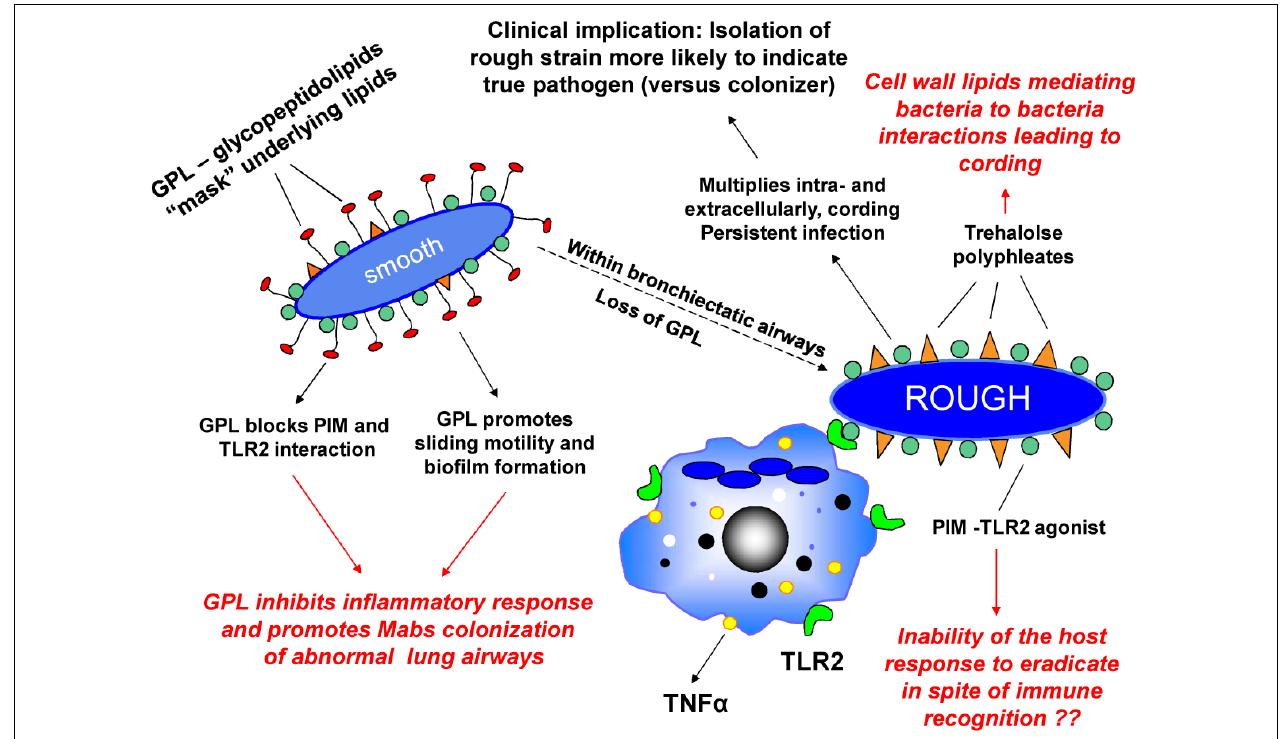
FIGURE 1 | Environmental Mycobacterium abscessus ( MABS ) isolates have the smooth colony morphotype and express glycopeptidolipid (GPL). GPL in the outermost aspect of the cell wall “masks” underlying glycosylated lipoproteins such as phosphatidyl-myo-inositol mannosides (PIMs) involved in immune recognition and blocks the bacterial cell–cell interaction of lipids such trehalose polyphleates which may play a role in clumping and cord formation. By preventing MABS from being recognized by innate immune surveillance mechanisms and promoting biofilm formation, GPL facilitates colonization of bronchiectatic lung airways. After colonization, spontaneous or temperature sensitive loss of GPL is associated with “unmasking” of these molecules. This leads to recognition by TLR2 on macrophages and respiratory epithelial cells resulting in release of the proinflammatory cytokines TNF α (from macrophages) and IL-8 (from respiratory epithelial cells). Rough variants acquire a virulent phenotype characterized by the ability to grow in serpentine cords and cause macrophage apoptosis leading to rapid cell–cell spread and propagation of infection. Isolation of MABS rough variants from the sputum is associated with progressive lung